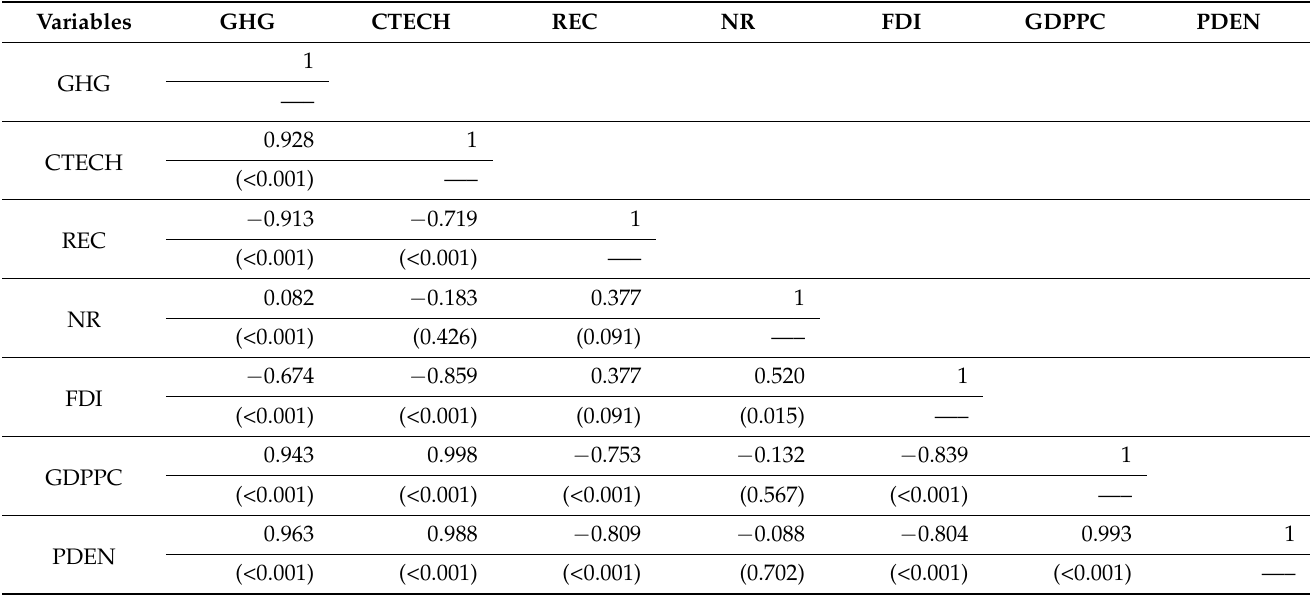
Table 3. Correlation